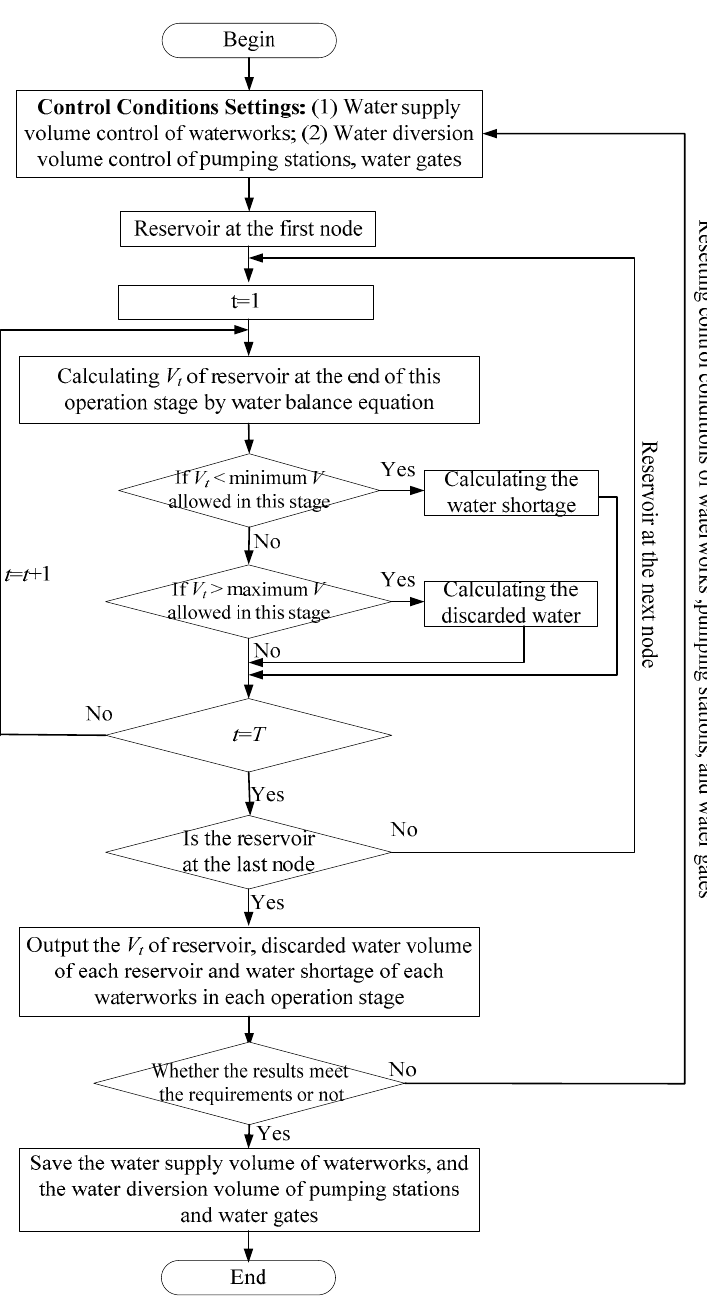
Figure 6. The core calculation process of the forward calculation mode.